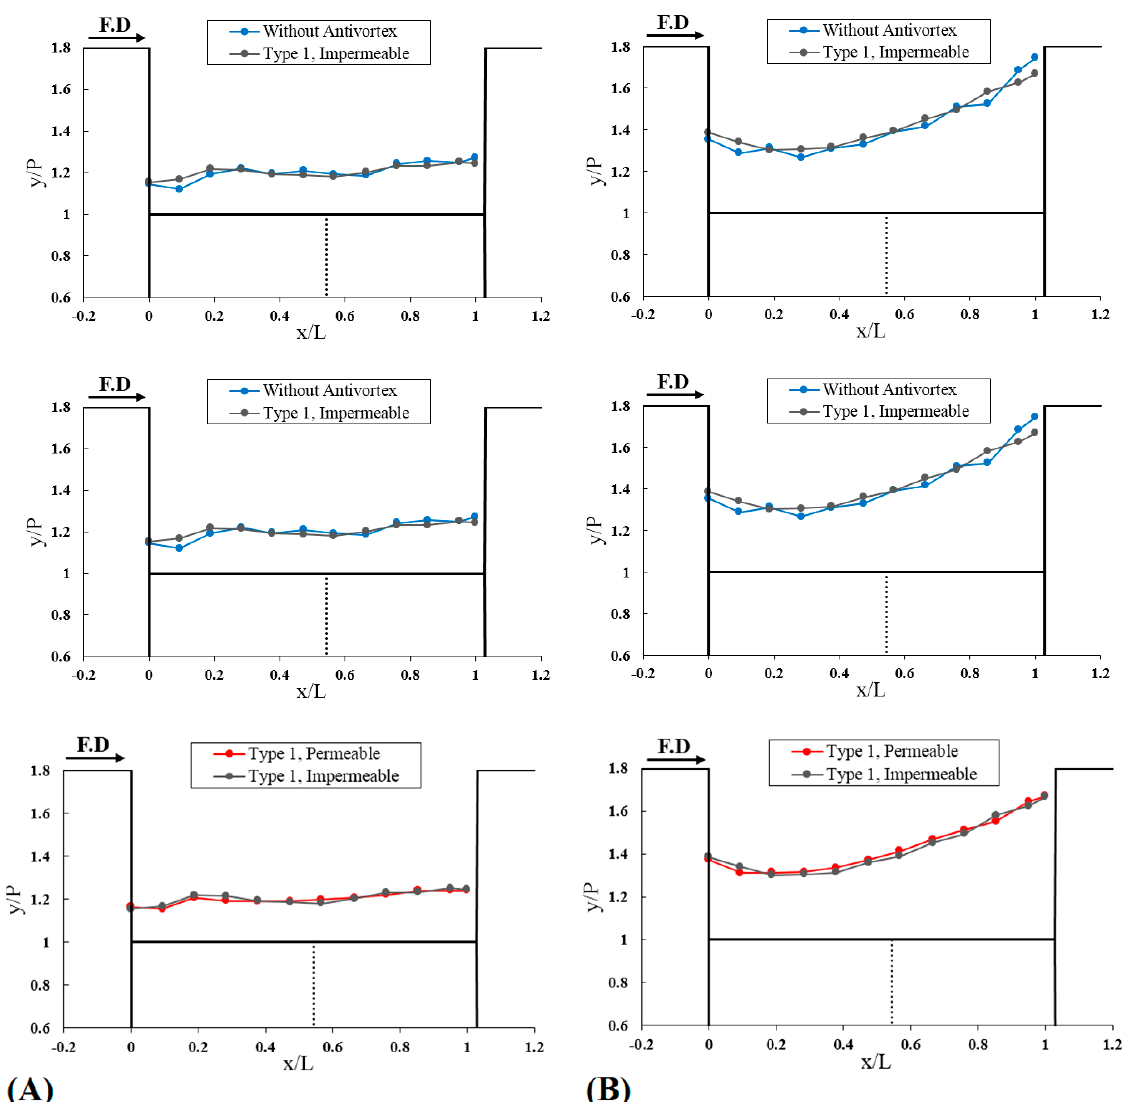
Figure 20. Free surface profile along the crest of the triangular labyrinth side weir with antivortexes. ( A ) Fr = 0.38; ( B ) Fr = 0.69.